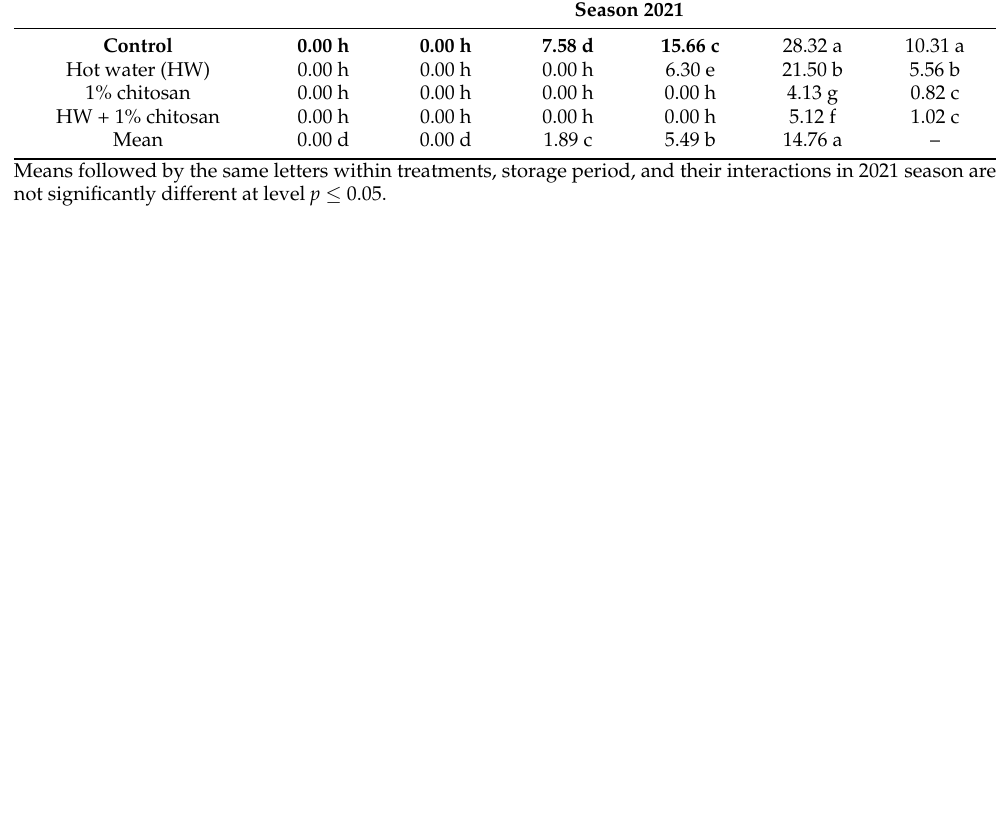
Table 2. Effect of hot water treatment and chitosan coating on postharvest decay (%) of mango fruits during storage at 13 ± 0.5 ◦ C and 85%–90% relative humidity (RH) for 28 days during 2021 season.